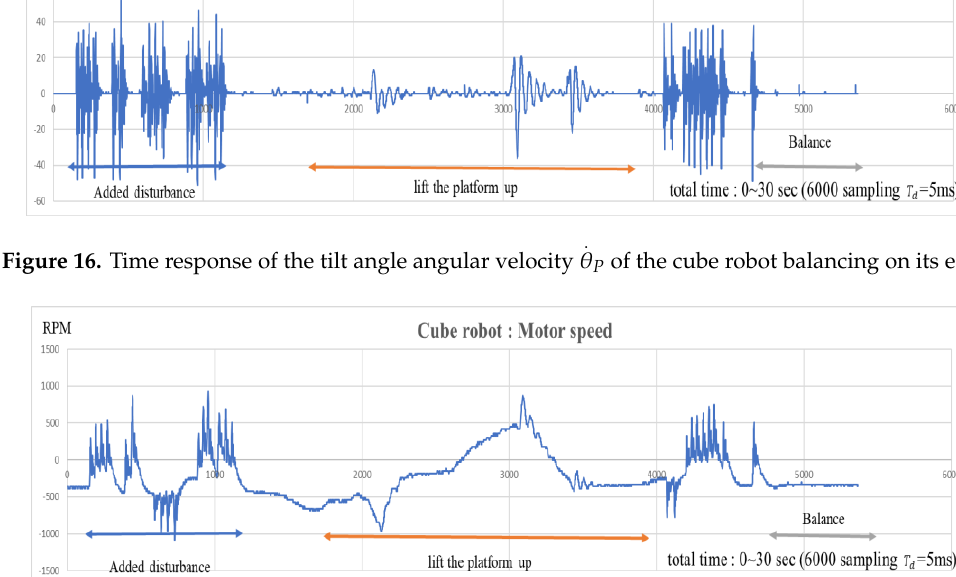
Figure 17. Time response of the motor speed 𝜃̇ 𝑤 of the cube robot balancing on its edge.